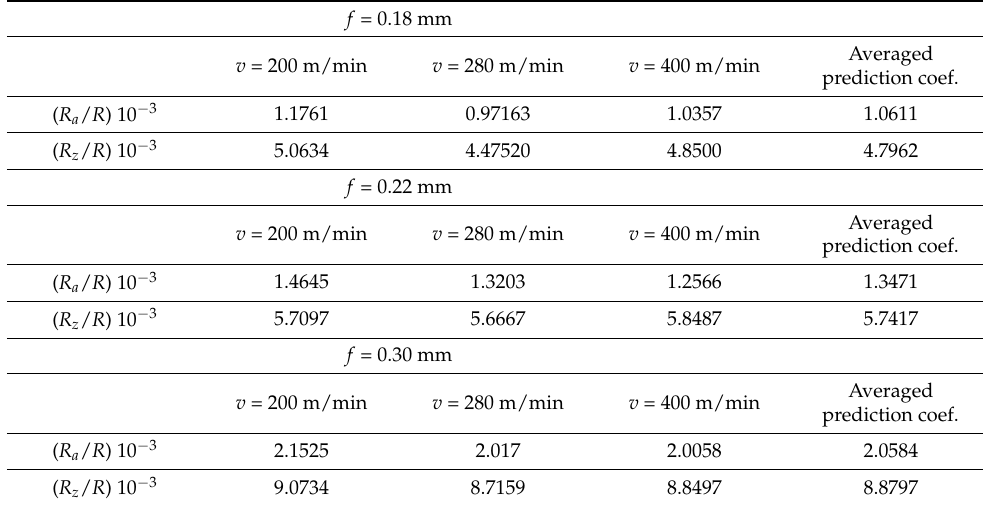
Table 4. Correlation parameters for surface roughness on amplitude of vibration.